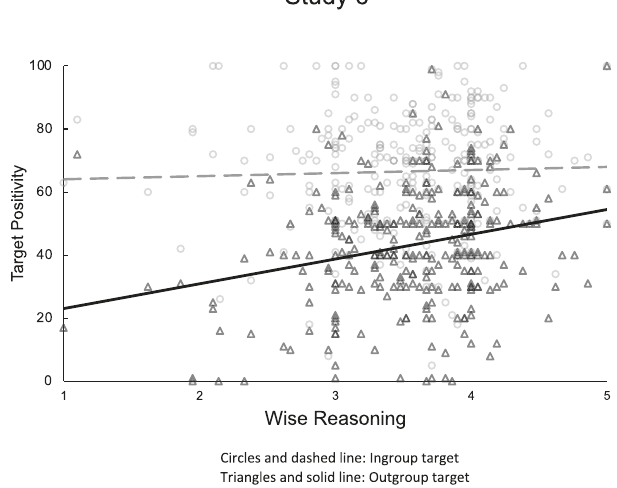
Fig. 3 Results from Study 3: within-subject positivity toward ingroup and outgroup targets in feeling thermometer ratings as a function of group members ’ level of wise reasoning. M wise reasoning = 3.56, SD =